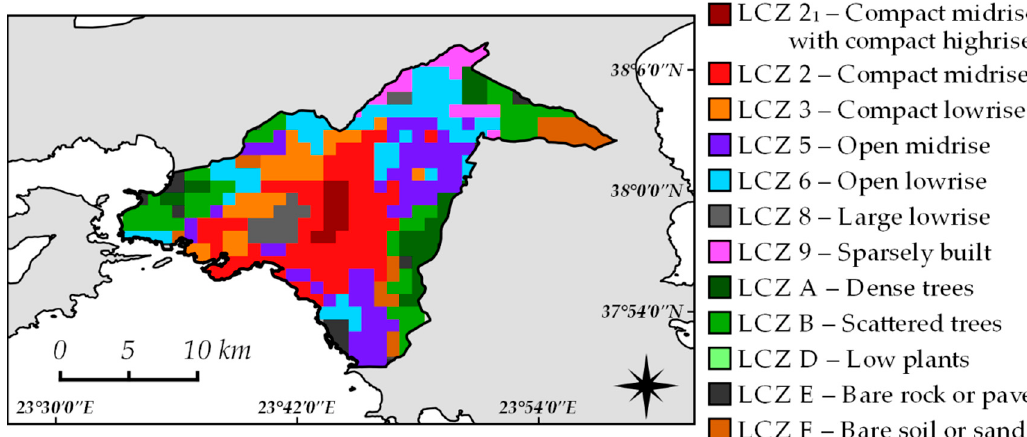
Figure 4. Mapping of the Local Climate Zones (LCZs) in Athens at 1 km resolution.